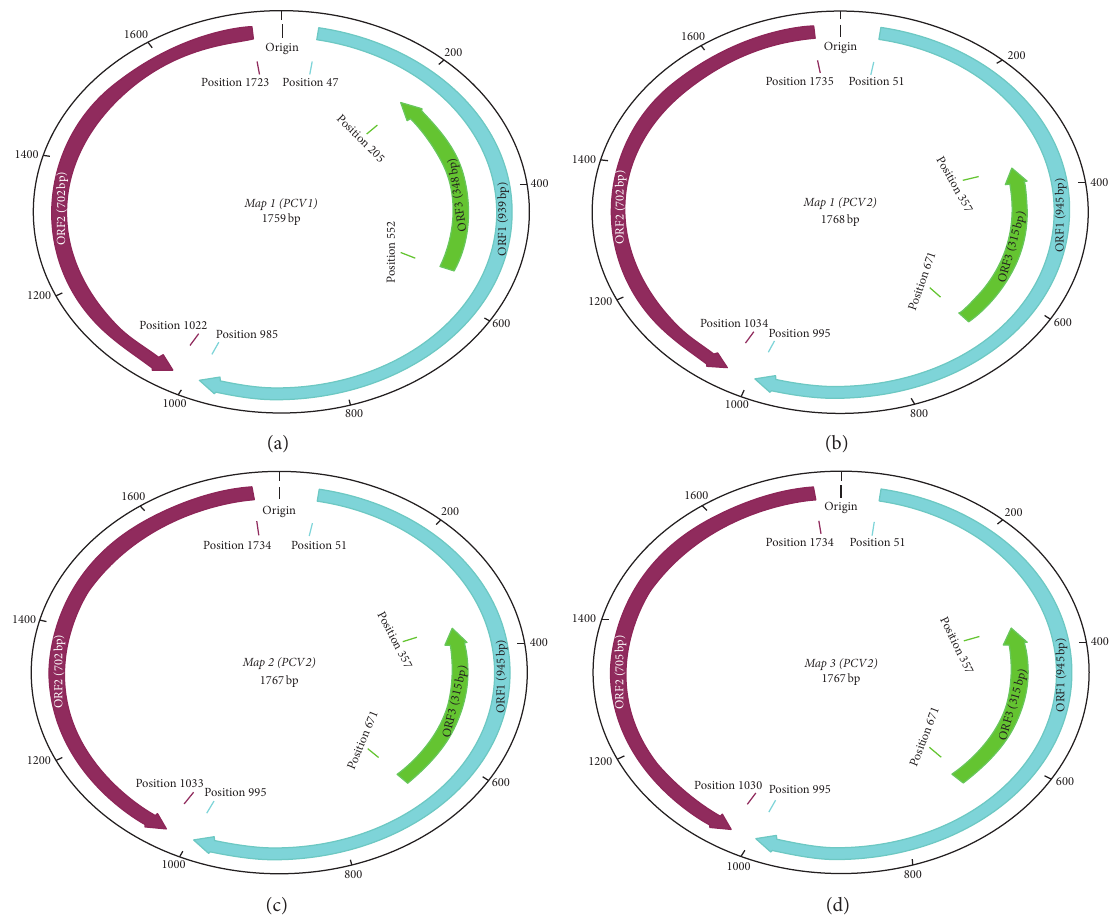
Figure 1: Genome organization of Porcine circovirus (NB: map (a) is for PCV1, while maps (b), (c), and (d) are for PCV2a and 2e; PCV2b and PCV2c and 2d, resp.), adapted from Zhai et al.